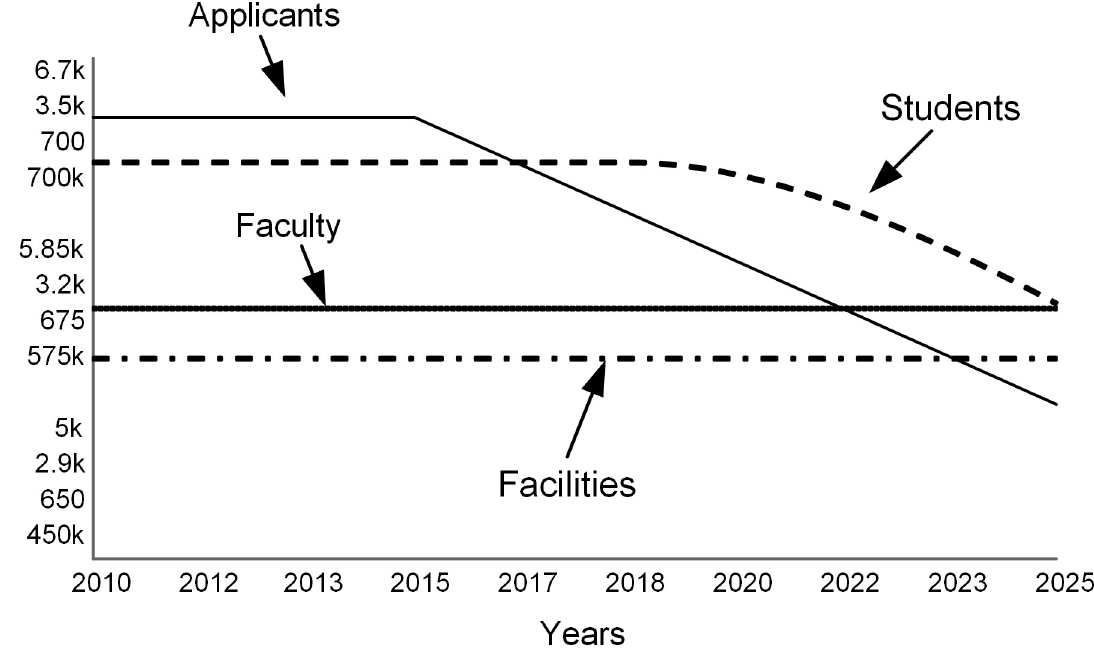
Fig 9. As applications drop by 15% over ten years, student enrollments decline. Faculty and facilities stay unchanged.